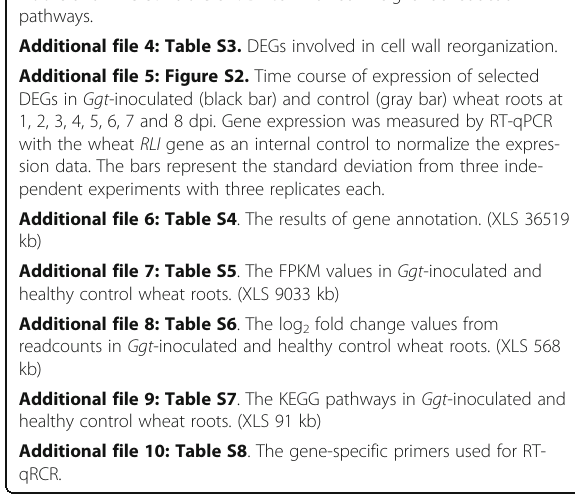
Additional file 3: Table S2. DEGs involved in signal transduction pathways. Additional file 4: Table S3. DEGs involved in cell wall